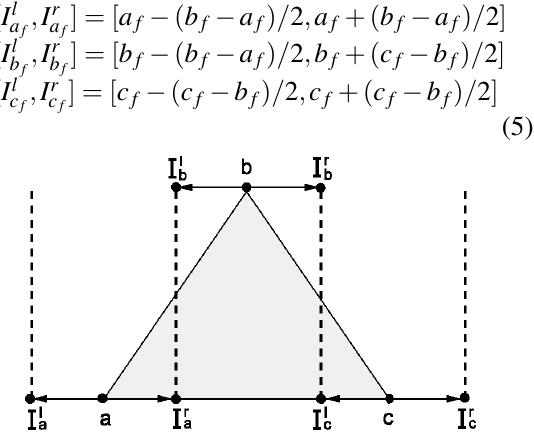
Fig. 10. The variation